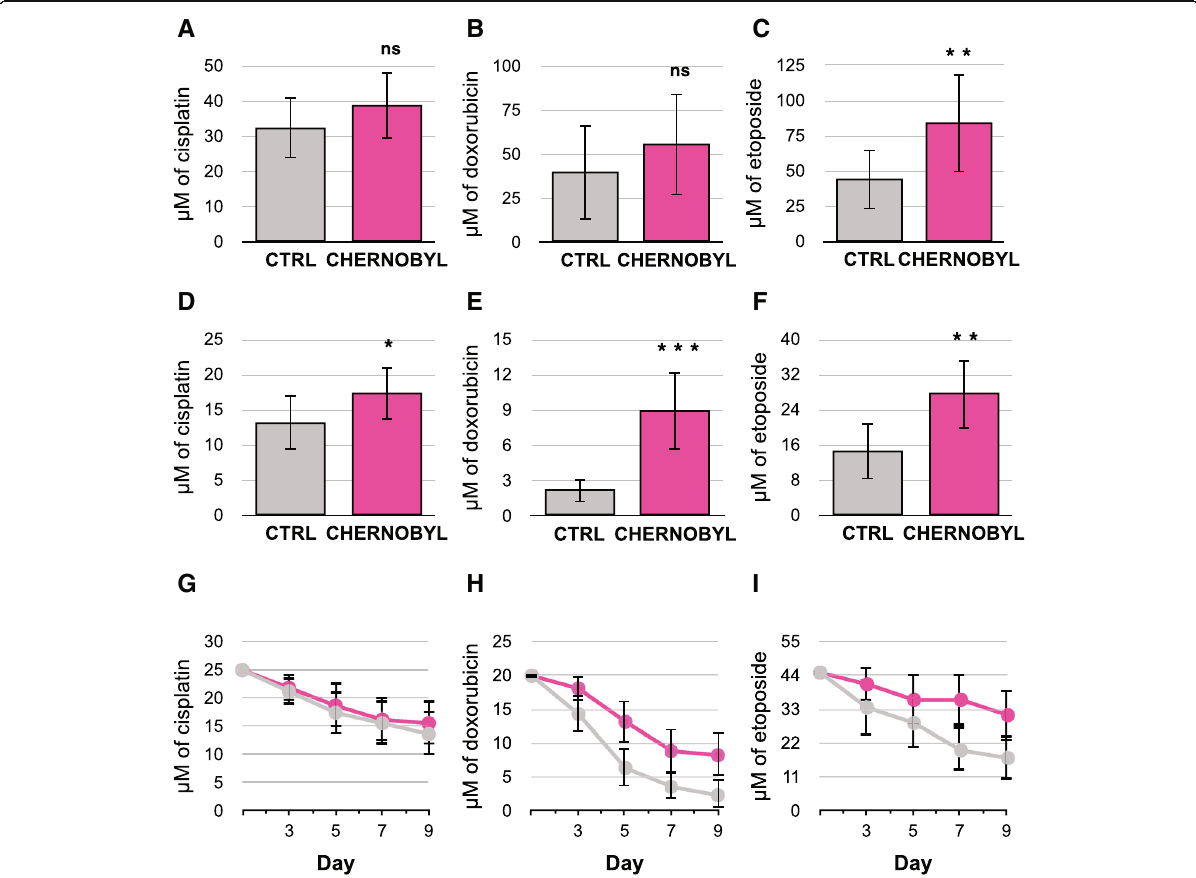
Fig. 3 Chernobyl bank vole fibroblasts survive on higher concentrations of DNA damaging drugs than control cells. Cells were plated at 80% confluency and treated with different concentrations of the DNA damaging drugs for 24 h after which fresh cell culture media was changed and the cells were let to grow for 7 days before scoring the wells that were 100% confluent. Treatment with a .) cisplatin or b .) doxorubicin did not show significant difference between the Chernobyl and control cell lines, whereas Chernobyl cells were able to grow in, on average, about 30 μ M higher concentrations of c .) etoposide. For constant exposure of DNA damaging drugs cells were treated with the drug every other day for four times before scoring the wells that were 100% confluent. Chernobyl fibroblasts were able to grow in significantly higher chronic concentrations of D.) cisplatin, e .) doxorubicin and f .) etoposide than control cells. Examples from one experiment ( N = 8) on the effect of constant drug treatment on reduction of 100% confluent Chernobyl and control fibroblast cultures after treatment with g .) cisplatin, h .) doxorubicin, and i .) etoposide. Results, except g - i , are from three separate experiments using eight Chernobyl ( N = 24) and eight control ( N = 24) cell lines, variation is shown by standard deviation, and statistical analysis was done